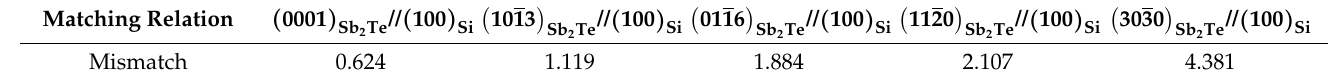
Table 4. Mismatch between the various crystal planes ((0001), Sb 2 Te thin film and the (100) crystal plane of Si substrate.